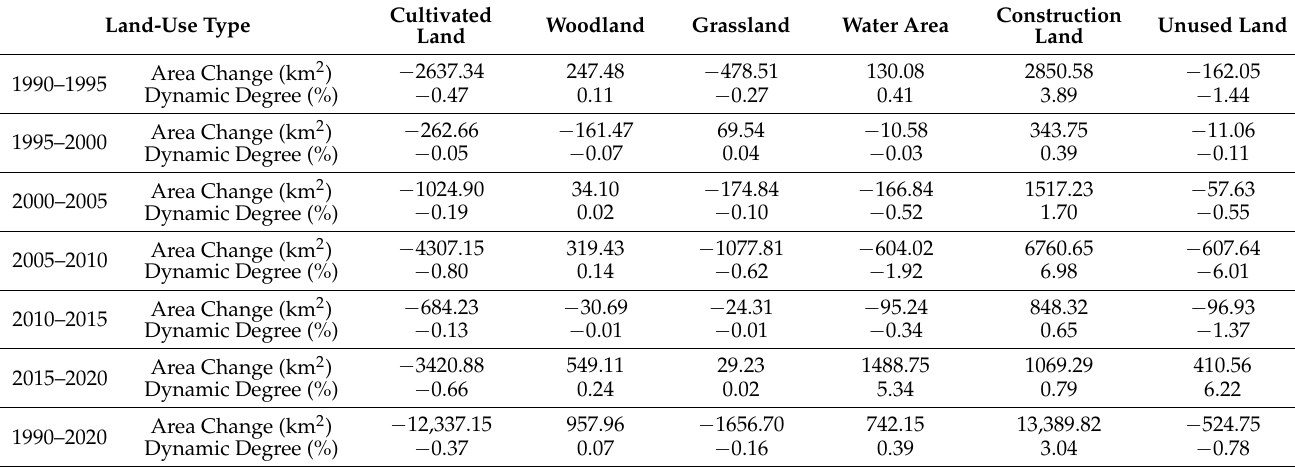
Figure 3. The land-use distribution from 1990 to 2020. Table 4. The changes in the area and dynamic degree of land use from 1990 to